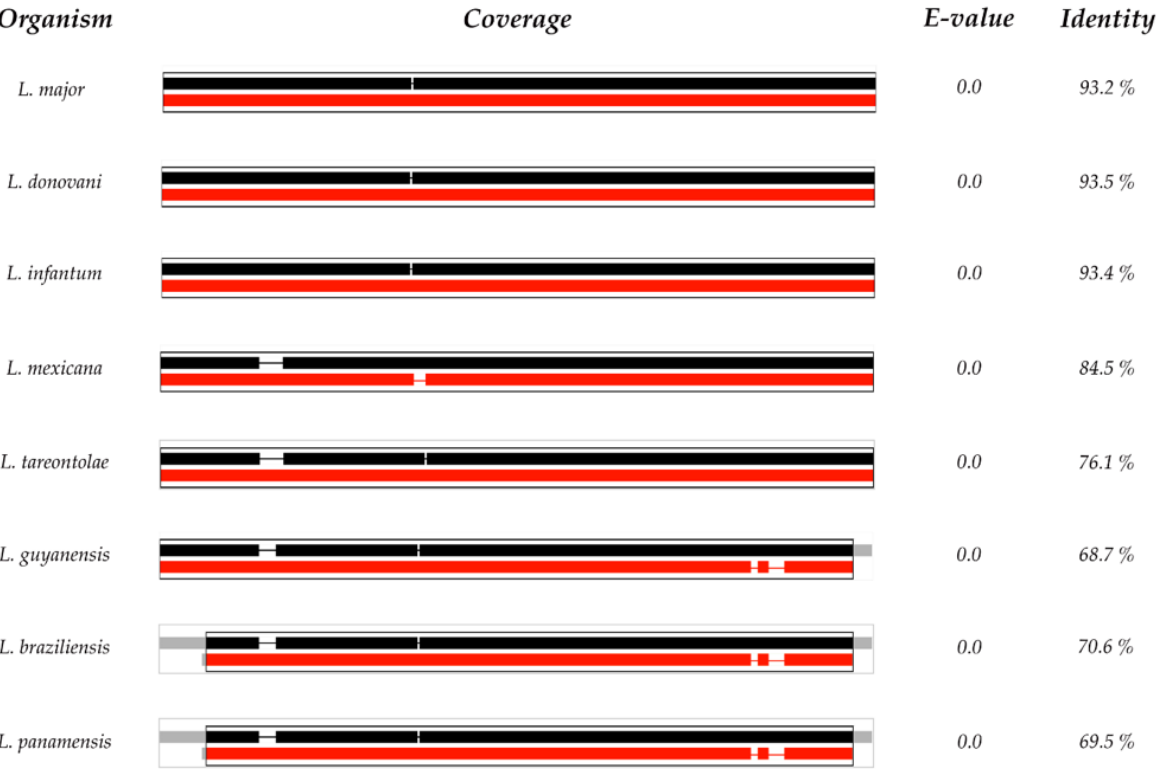
Figure 2. Uniprot Blast results. E-values and percentages of sequence similarity of L. amazonensis were compared with other Leishmania species. L. amazonensis sequence is represented in black, other Leishmania specie sequences are represented in red, and coverage is represented by box size.